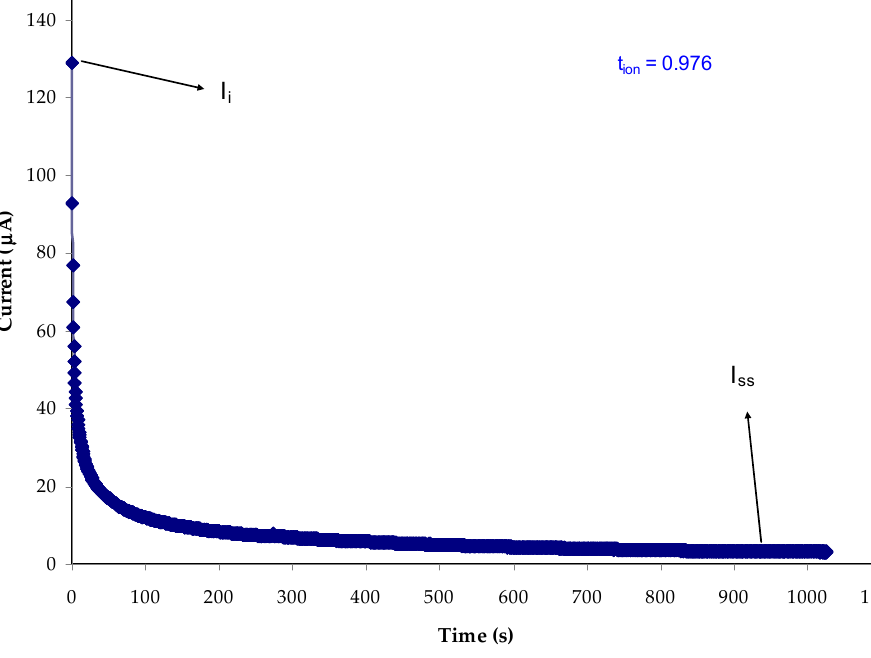
Figure 6. Chronoamperometric profile of for the MDLG3 electrolyte. Equations (17) and (18) are used to measure t ion and t el